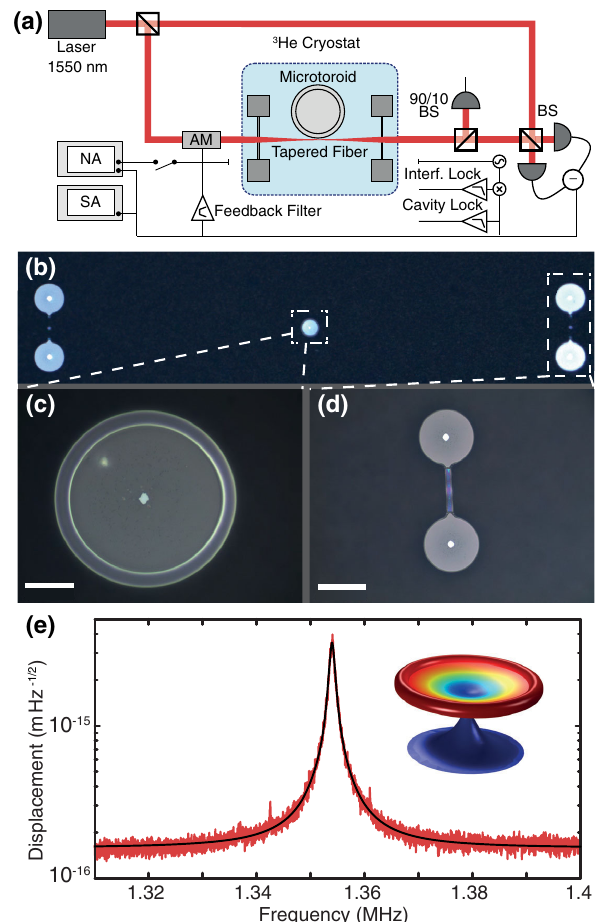
FIG. 2. (a) Experimental schematic. A microtoroid is nested inside an all-fiber interferometer and cooled by a He-3 refrig- erator (BS, beam splitter; AM, amplitude modulator; SA, spectrum analyzer; NA, network analyzer). (b) Optical micro- scope image of the microtoroid used in these experiments, showing the support beams, one on either side, that are used to stabilize the tapered optical fiber. (c) Zoomed-in microscope image of the microtoroid. Scale bar is 20 μ m long. (d) Zoomed-in microscope image of a stabilization beam. The circular pads support a suspended beam that has been thinned to 200 nm thickness in order to minimize optical scattering loss. Scale bar is 100 μ m long. (e) Thermal motion of the flexural mode of a microtoroid at 3 K. Inset: FEM simulation of the mechanical displacement